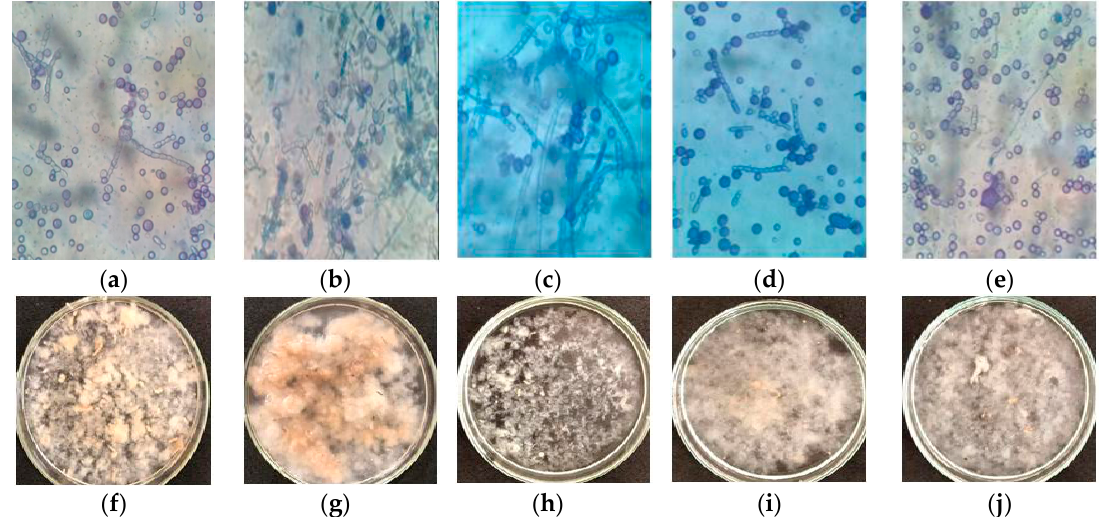
Figure 1. Morphological aspects of Mucor subtilissimus UCP 1262 cultivated in different concentrations of CSL and CWW according to 2 2 factorial design for 120 h. ( a , f ): Assay 1; ( b , g ): assay 2; ( c , h ): assay 3; ( d , i ): assay 4; ( e , j ): center point. * Assay 1: 2% CSL and 4% CWW; assay 2: 6% CSL and 4% CWW; assay 3: 2% CSL and 8% CWW; assay 4: 6% CSL and 8% CWW; center point: 4% CSL and 6% CWW. Bars: 10 μ m.